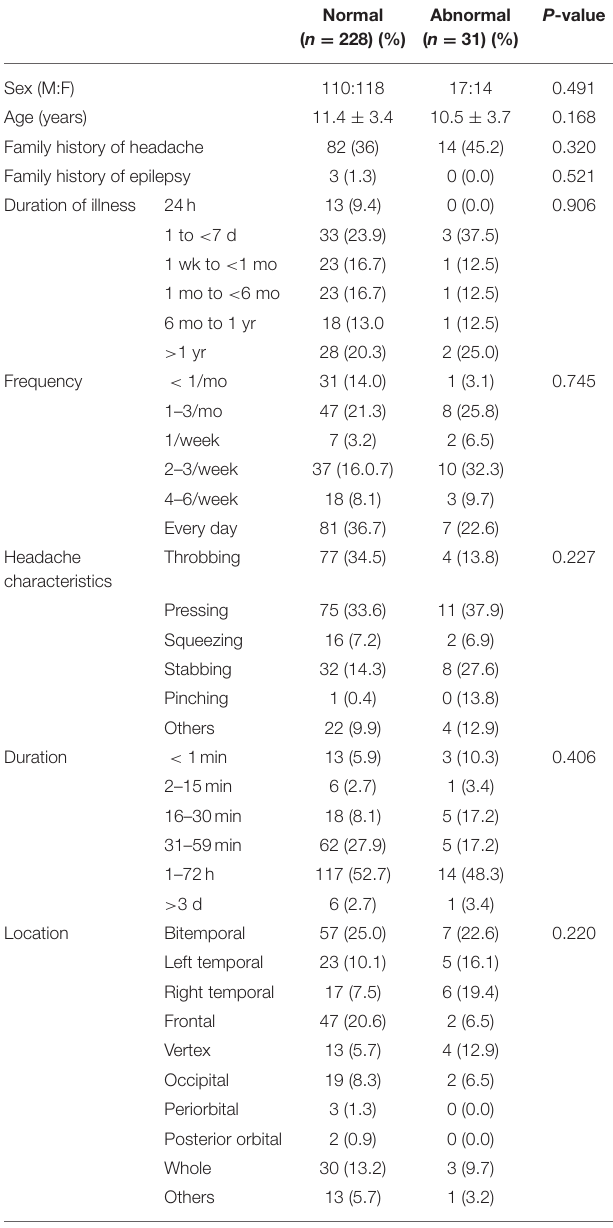
TABLE 3 | Comparison of clinical characteristics between headache patients with normal and abnormal electroencephalograms (EEG).